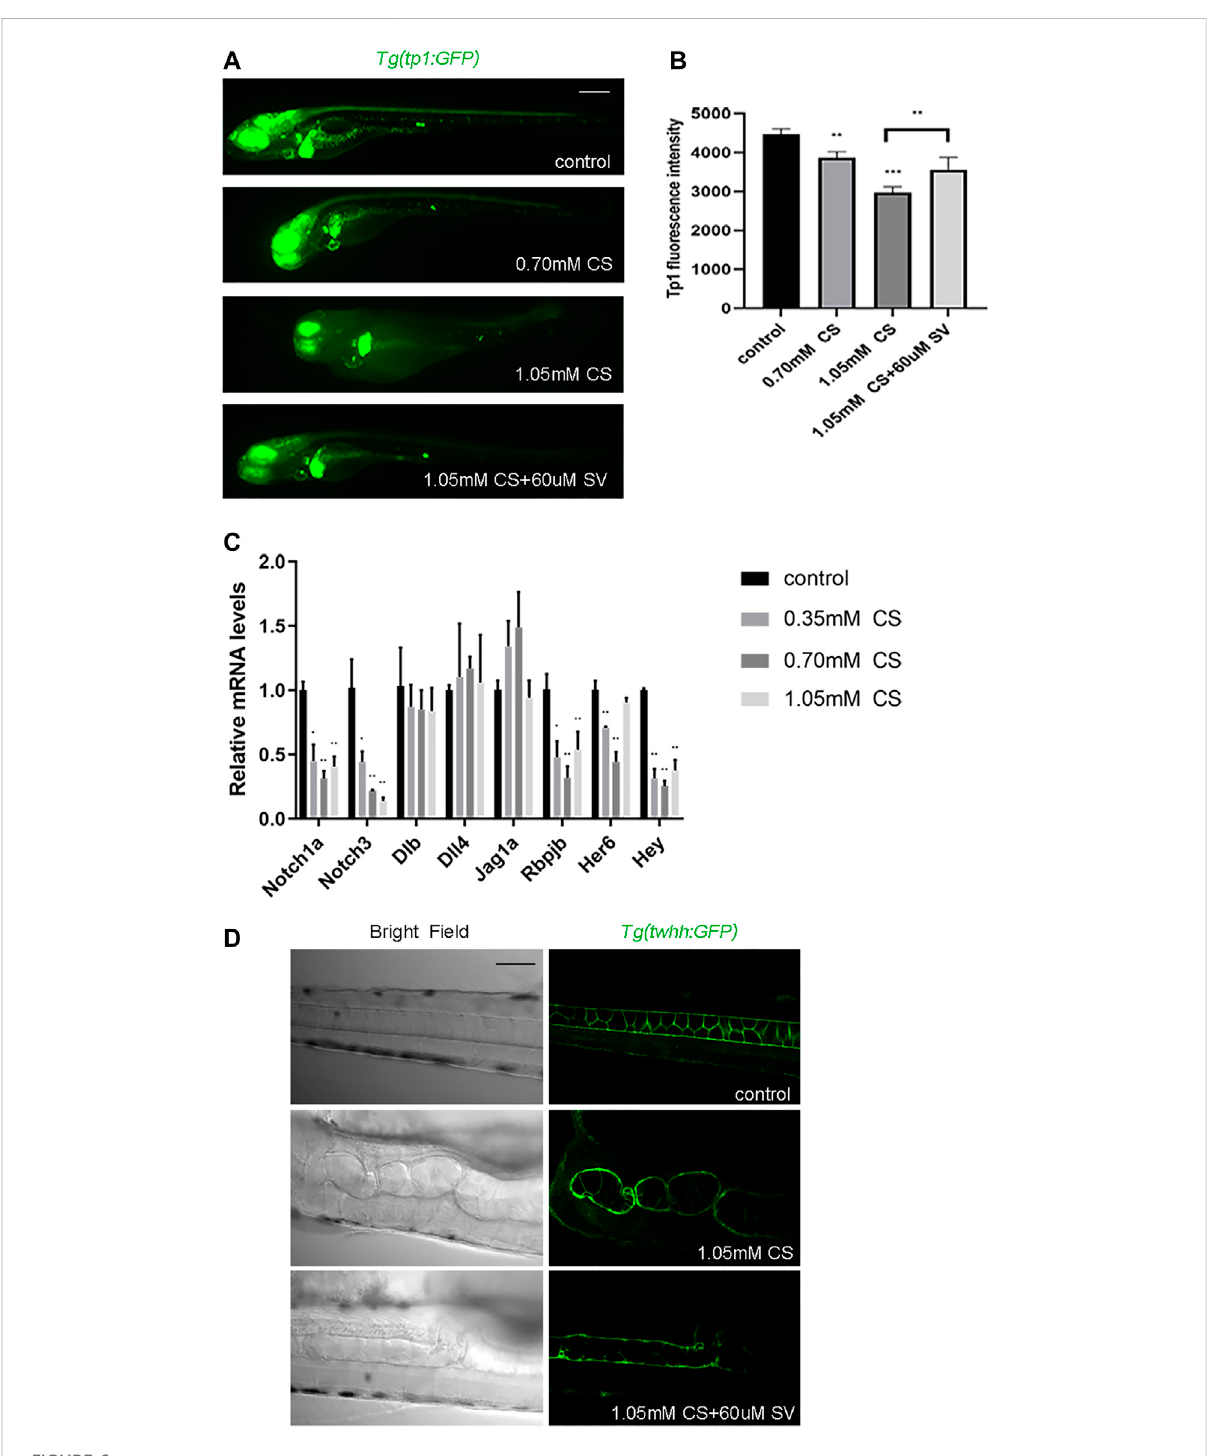
FIGURE 6 Notch signal rescued the skeletal development defects caused by cysteamine. (A) Tg (tp1: GFP) microscopic imaging of zebra fi sh larvae exposed to 0.35, 0.70, and 1.05 mM cysteamine, and 1.05 mM cysteamine with 60 μ M sodium valproate at 72 hpf. (B) Tg (tp1: GFP) fl uorescence intensity of zebra fi sh larvae exposed to 0.35, 0.70, and 1.05 mM cysteamine, and 1.05 mM cysteamine with 60 μ M sodium valproate at 72 hpf. (C) Expression analysis of genes related to Notch signaling pathway. (D) Microscopic imaging of zebra fi sh Tg ( twhh: GFP ) larvae exposed